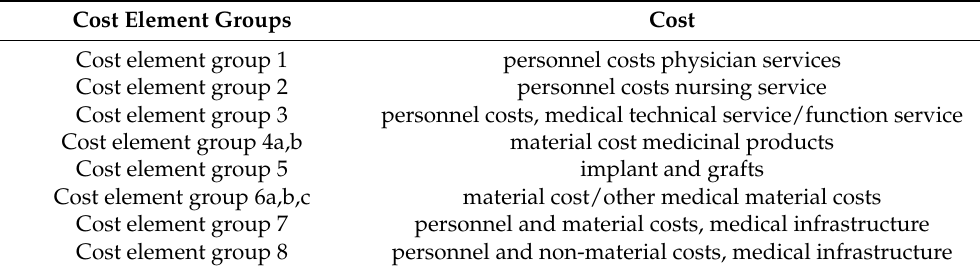
Table 1. Cost element groups (according to the InEK calculation manual